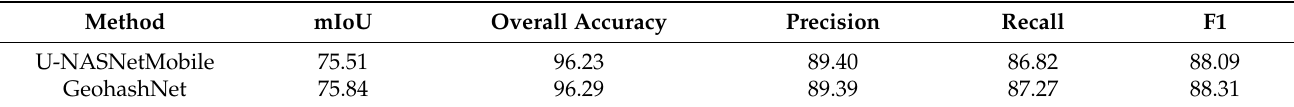
Table 6. More measurements of results for the Inria dataset.